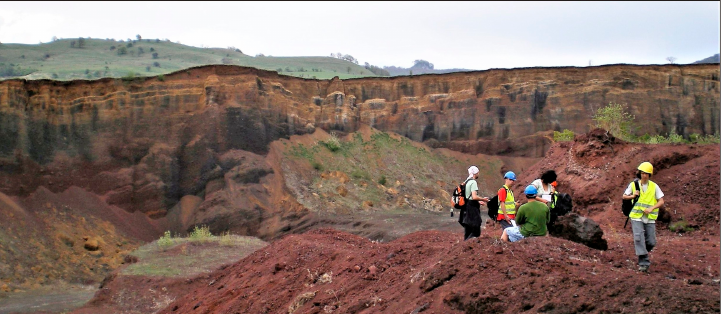
Figure 21. The interior precinct of the eviscerated Heghie ș scoria cone at Raco ș ul de Jos, Per ș ani Mountains. Persons in the picture are visiting geology students in field practice. (Photo: Alexandru Szakács).